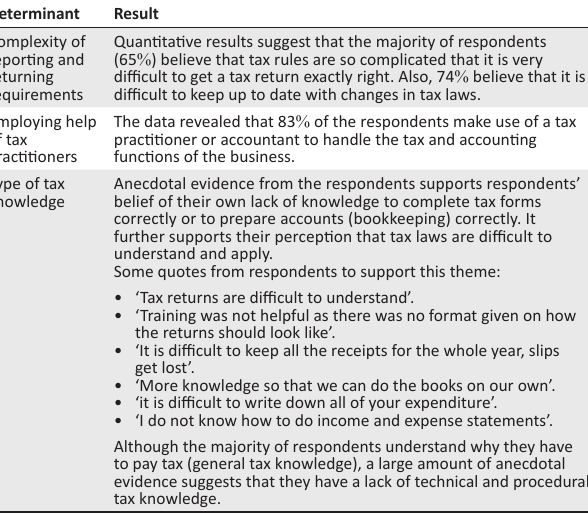
TABLE 3: Results of the analysis for the population surveyed using the factor ‘Knowledge